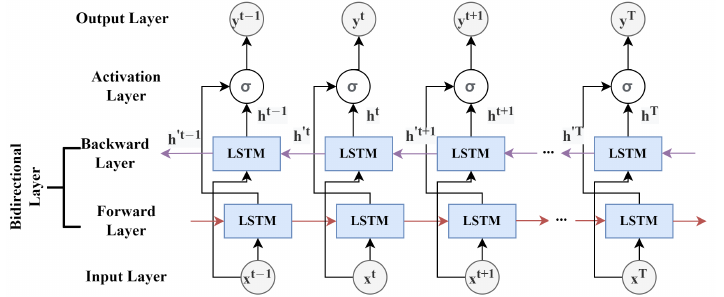
Figure 4. The structure of a bidirectional